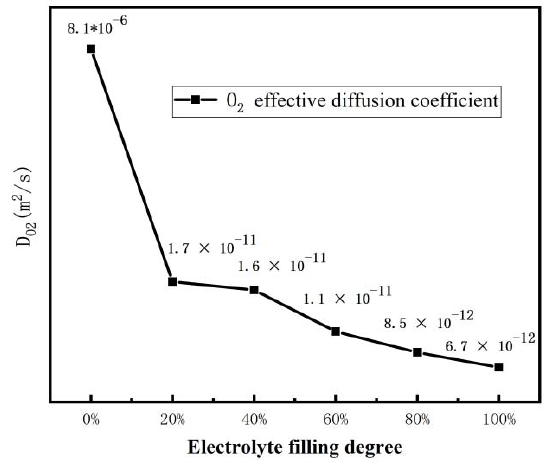
Figure 8. Oxygen effective diffusion coefficient.